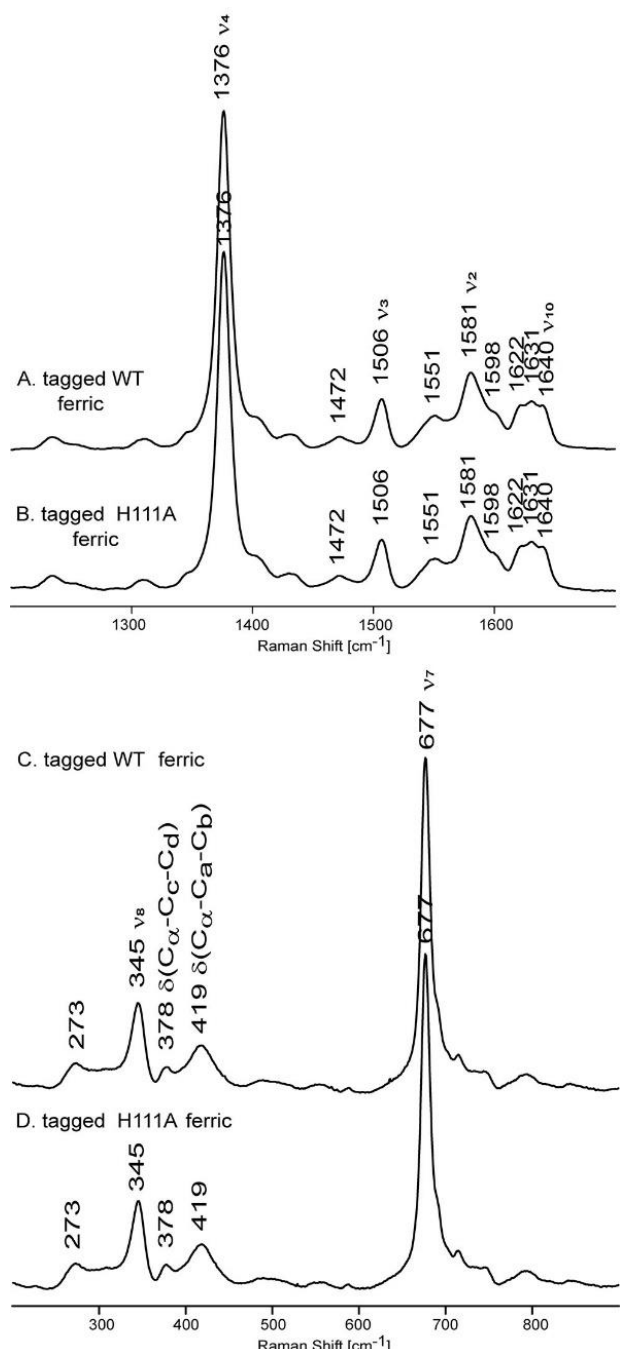
Figure 3. The resonance Raman (rR) spectra of HupZ and the H111A variant. ( A ) Ferric HupZ-heme complex and its ( B ) H111A mutant in the high frequency region, and the corresponding spectra in the low frequency region ( C , D ). All samples were measured with 406 nm excitation line at room temperature.